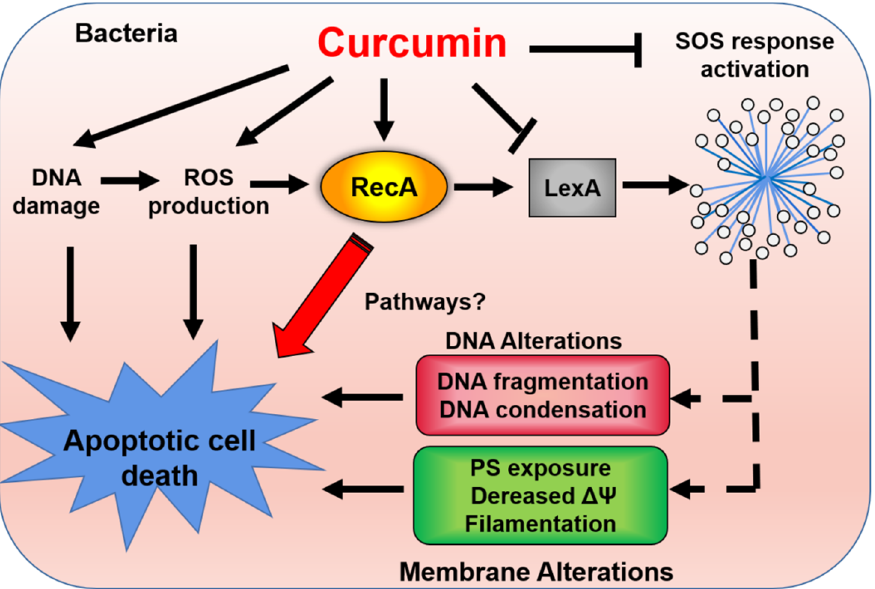
Figure 5. Curcumin induces oxidative stress, DNA damage, and apoptotic-like death in bacterial cells. Stress caused by drugs or other factors in bacterial cells could induce the production of ROS or DNA damage, following by activating the expression of RecA, DNA fragmentation, decreased membrane potential ( ∆Ψ ), and formation of filamentation, finally leading to cell death. In response to this stress, the SOS response network is usually activated and plays a protective role in bacterial survival